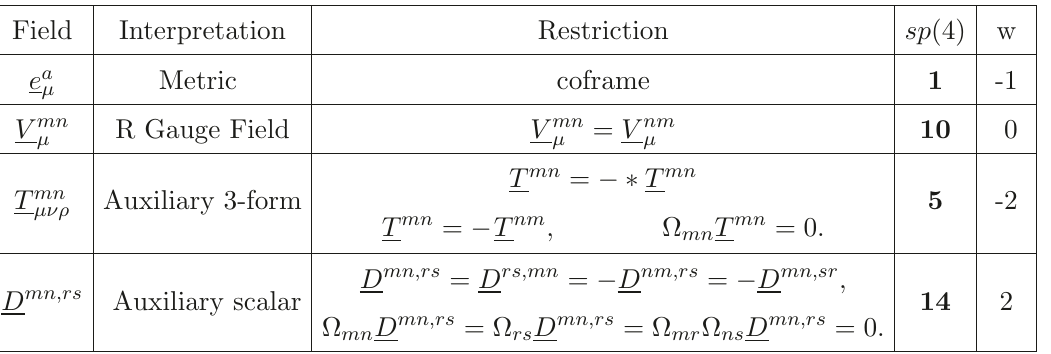
Table 2 . Bosonic fields of 6d (2,0) off shell